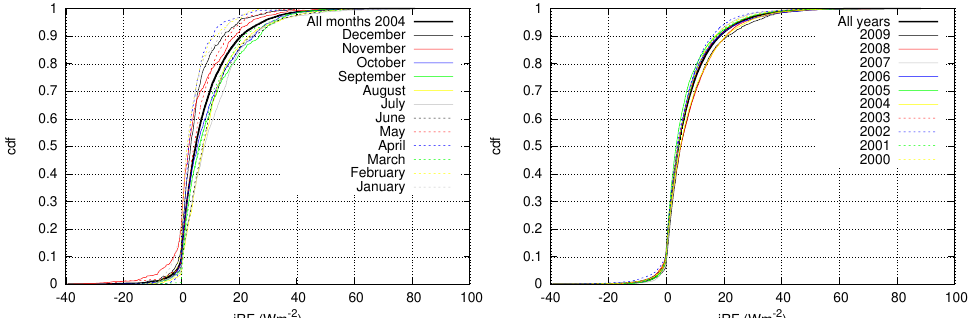
Figure 1. Cumulative distribution functions (cdfs) of instantaneous radiative forcing from persistent contrail situations selected from the MOZAIC dataset. The left panel displays the cdfs for each month in 2004 (coloured) together with the cdf for the whole year (black), the right panel shows the cdfs for each year 2000 to 2009 (coloured) together with the cdf for the complete